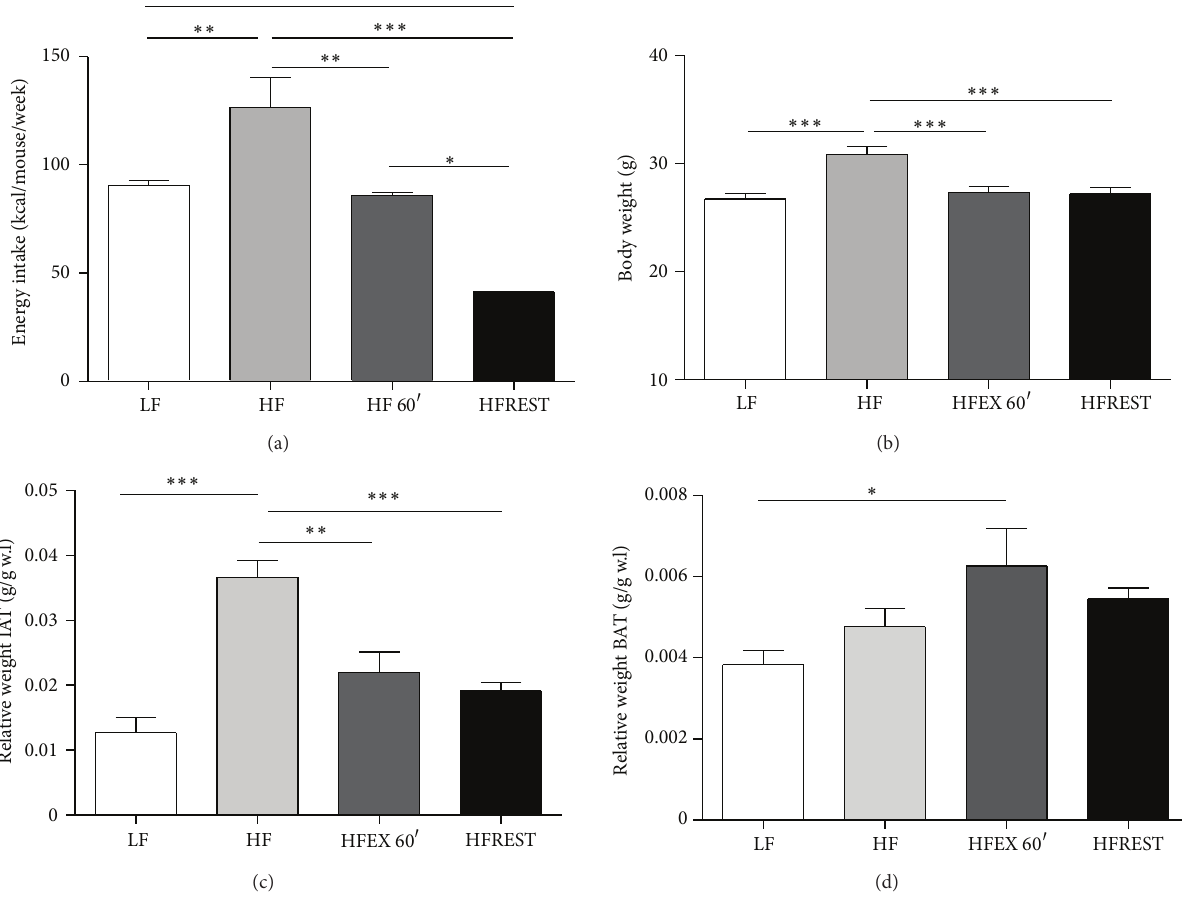
Figure 1: (a) Weekly caloric intake of animals subjected to the control diet (LF), high-fat diet (HF), high-fat diet with exercise (HFEX 60 󸀠 ), and high-fat diet with 30% food restriction (HFREST). (b) Mouse body weights (g). (c) Relative weight of IAT (inguinal adipose tissue). (d) Relative weight of BAT (brown adipose tissue). Mean ± SEM, 𝑛 = 5 mice per group. ∗∗∗ 𝑃 < 0.001 , ∗∗ 𝑃 < 0.01 , ∗ 𝑃 < 0.05 .